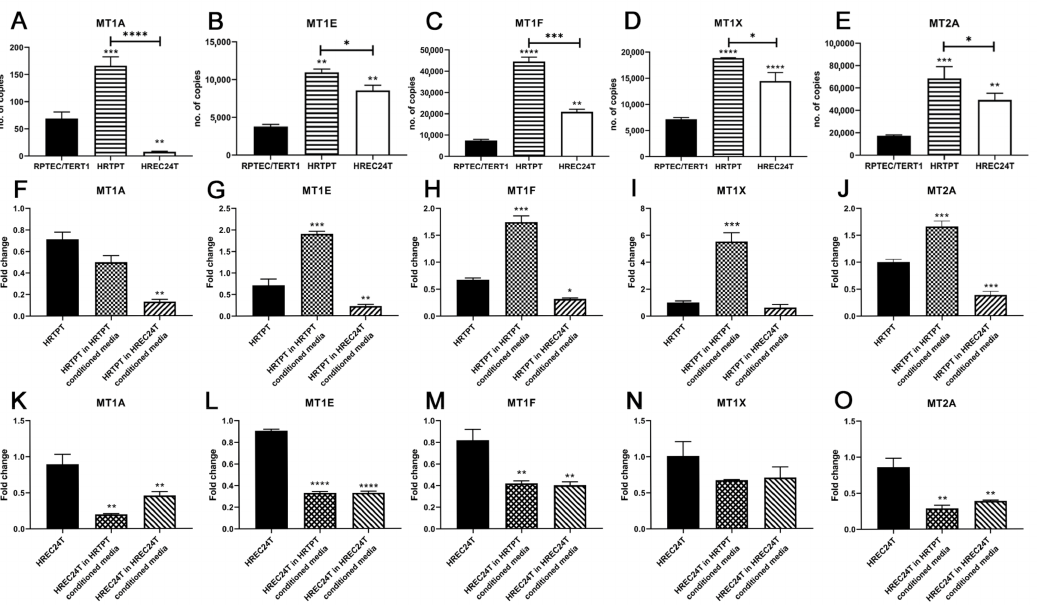
Figure 4. Expression of metallothionein genes in HRTPT and HREC24T cells exposed to